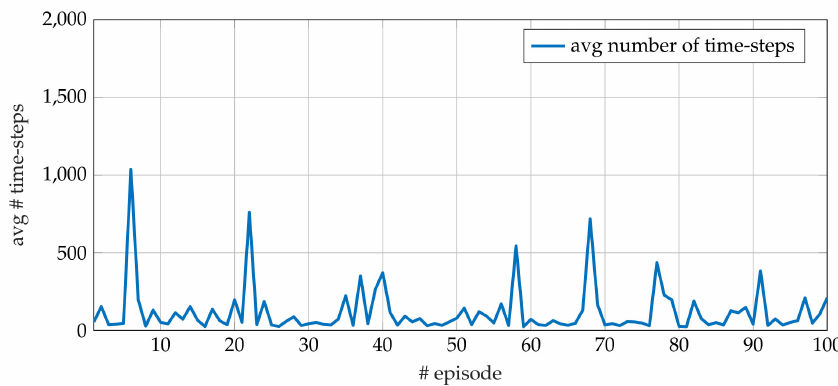
Figure 4. Average number of time-steps for each episode during the 10 runs in the test performed on the EOS